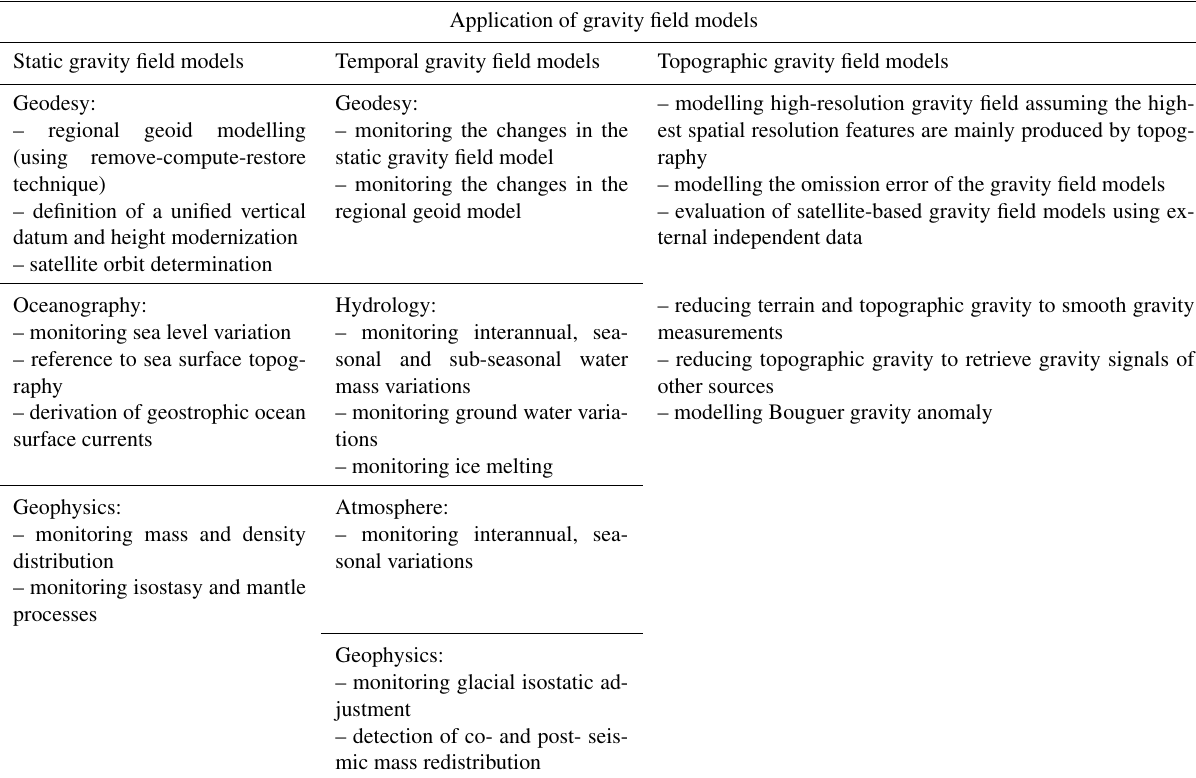
Table 1. The application areas of the global gravity field models. Note that the variations refer to the mass